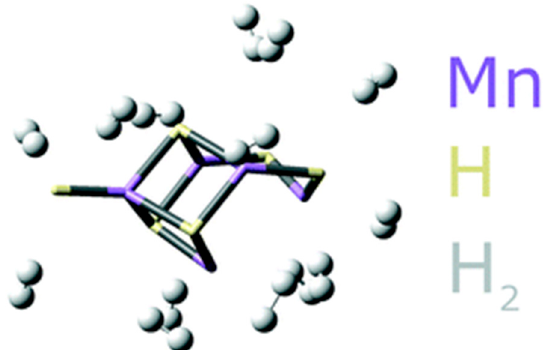
Figure 4. Computer simulated representation of 10 dihydrogen molecules attached to the manganese hydride basic compound in their possible binding sites. Basic compound represented as tubes while H 2 appears as balls and sticks. Reprinted from Ref. [156]; Copyright Royal Society of Chemistry 2019.